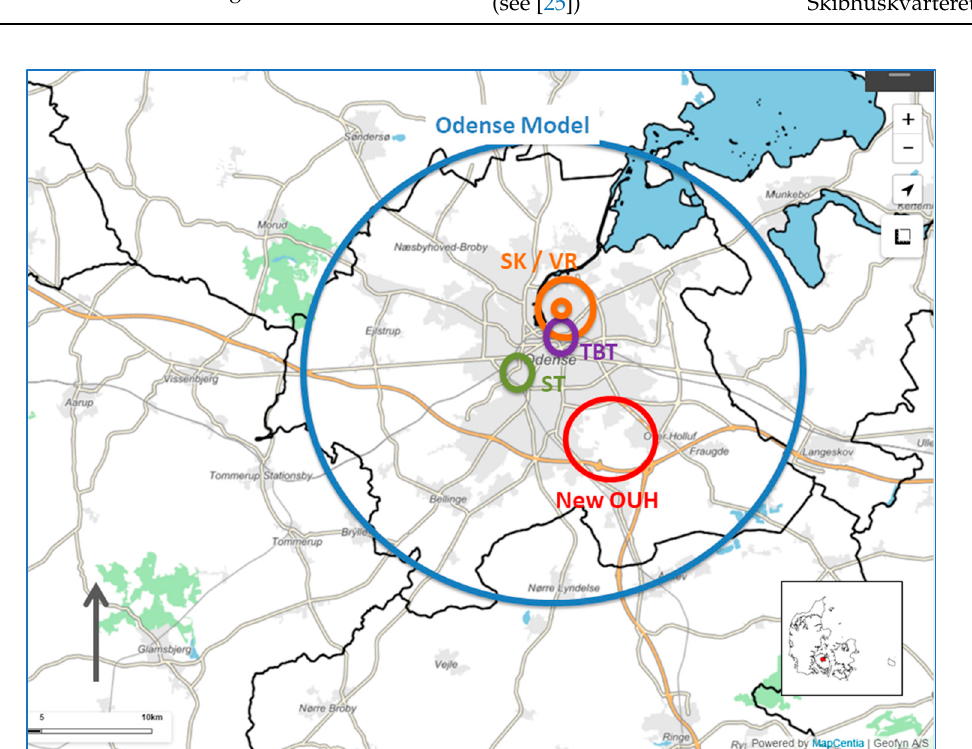
Figure 4. Location of projects used for development of a conceptual design of The Odense Model. (SK/VR) Skibhuskvarteret/Vinkælderrenden, (TBT) Thomas B. Thrigesgade, (ST) Sanderum Tørvehave, (New OUH) New Odense University Hospital (for descriptions see Table 5).